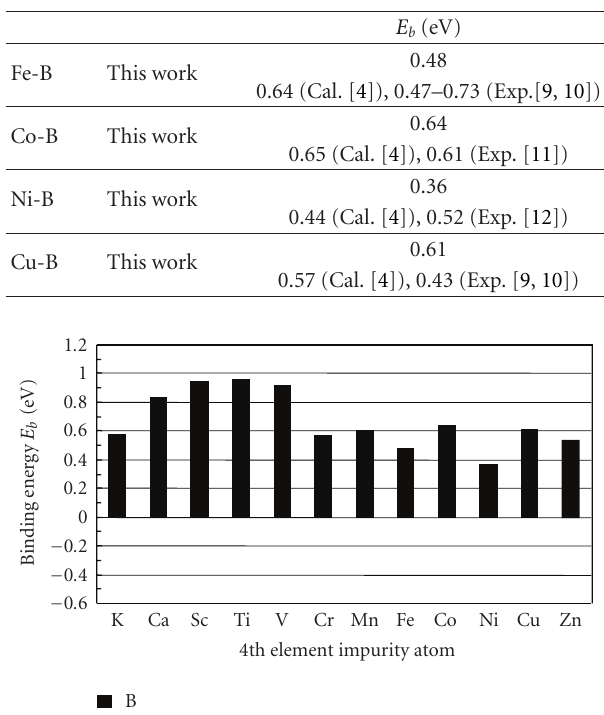
Table 1: Binding energy E b of B to Fe, Co, Ni, and Cu atoms.